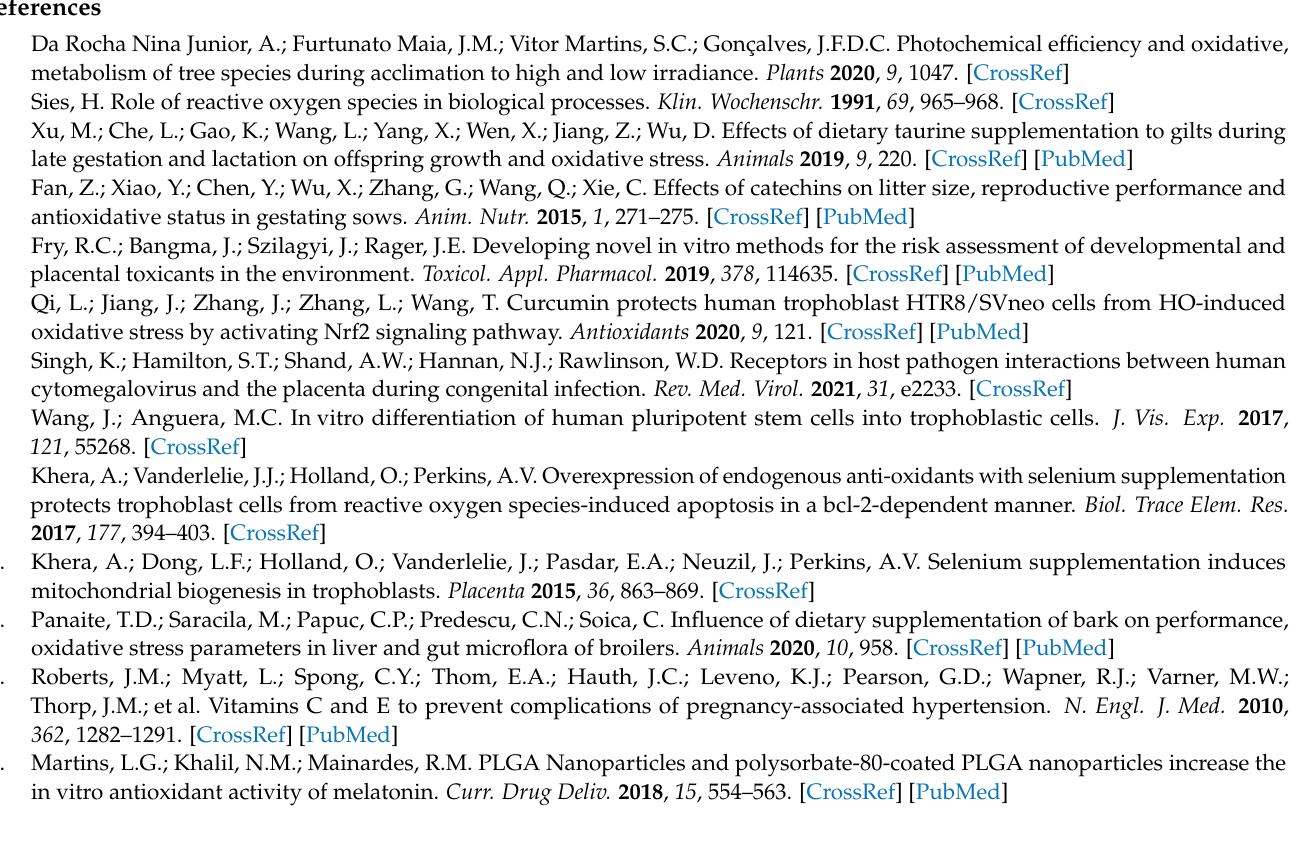
Table S4: Hub genes ranked by the Degree method in CytoHubba (MH VS. H 2 O 2